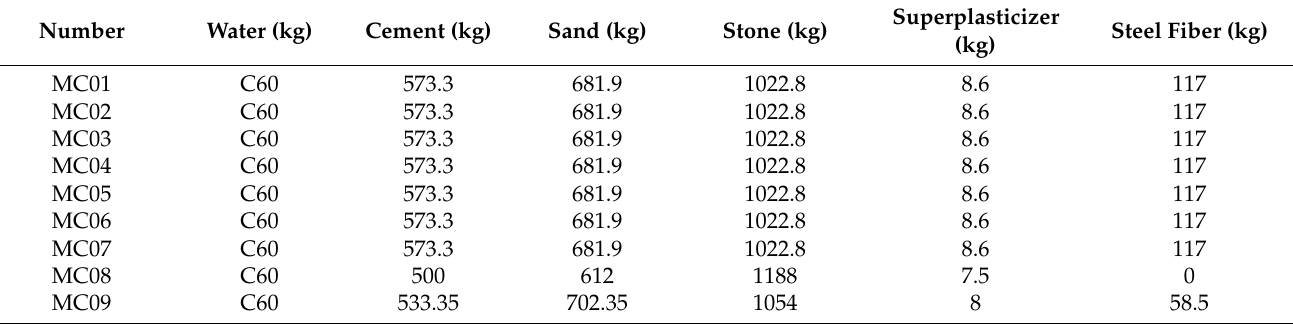
Table 2. Mixing proportions of C60 steel fiber concrete.